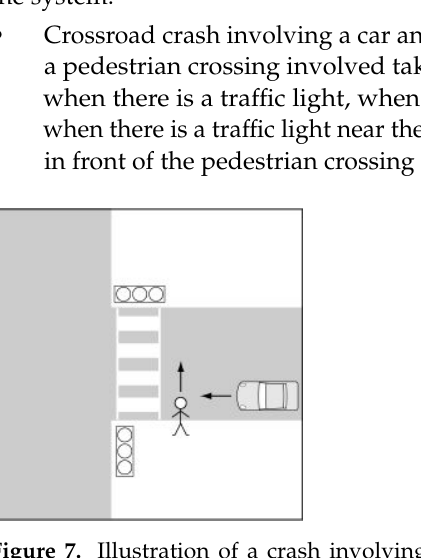
Figure 7. Illustration of a crash involving a car and a pedestrian at an intersection in front of the pedestrian crossing. From https://jiko-online.com/wp/kasitu/jiho-oudan/ (accessed on 8 September 2022).